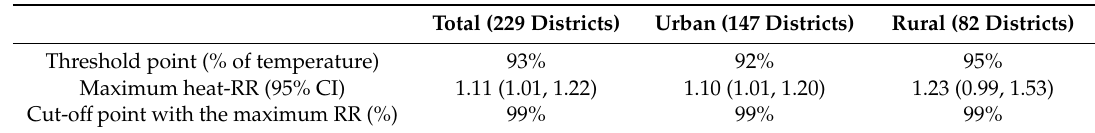
Table 2. Threshold point, cut-off point with the maximum RR, and the maximum value of pooled heatwave-related mortality risk (RR) in the total, urban, and rural areas. Total (229 Districts) Urban (147 Districts) Rural (82 Districts) 99% 99% Cut-off point with the maximum RR (%) 99%